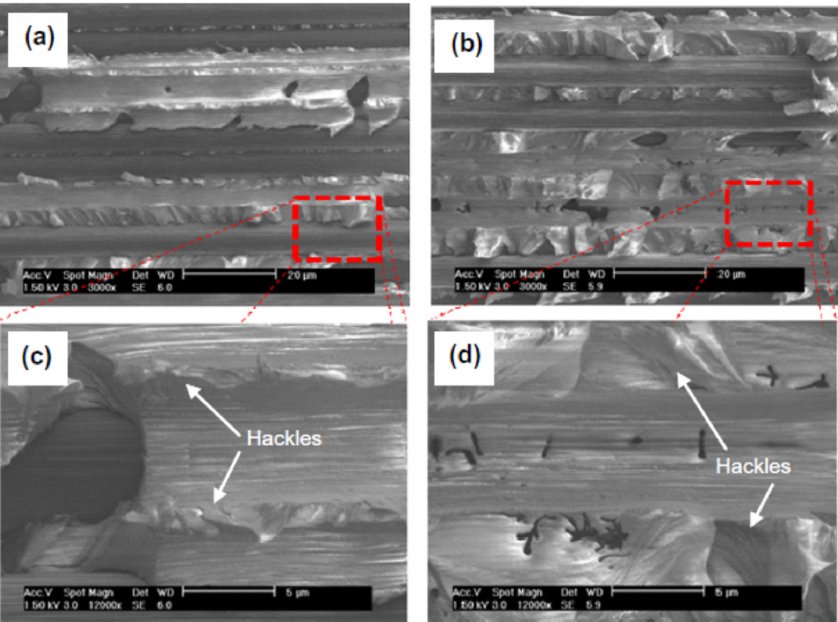
Figure 14. SEM of fractured Mode II DCB coupons at different magnifications for ( a , c ) baseline laminate and ( b , d ) SWCNT-modified laminate. The existence of larger hackles can be seen